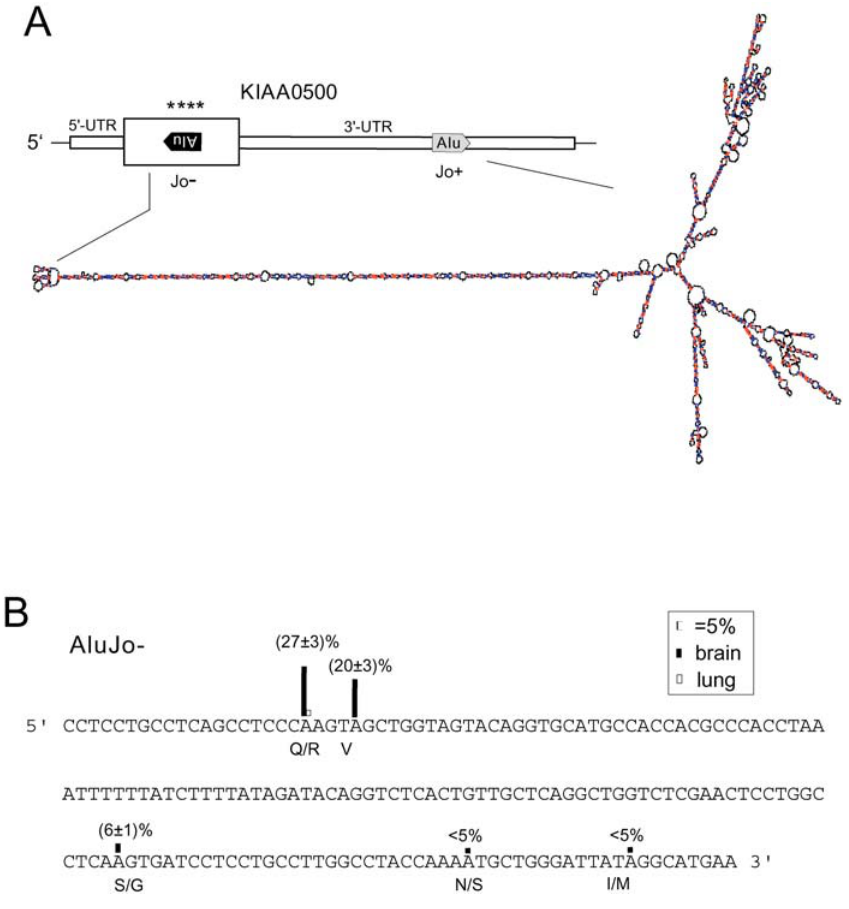
Figure 2. RNA Editing of KIAA500 Alu Inverted Repeat KIAA0500 is a cDNA of 6,577 nt in length cloned from human brain (AB007969) with a predicted open reading frame of 213 amino acids. Four AtoG discrepancies were present within the coding region of which two lead to an amino acid change (Q/R and S/G, respectively). (A) Structure of the KIAA500 mRNA with location of Alu elements indicated and the predicted RNA secondary structure according to the MFOLD algorithm. Large open box indicates predicted open reading frame. *, editing sites. (B) Editing analysis of an exonic Alu element in KIAA0500. Editing sites pre- dicted to change amino acids are indi- cated. Our analysis revealed a significant percentage of editing (%G) at the nucleo- tide positions 3518 (27% 6 3%), 3522 (20% 6 3%) and 3625 (6% 6 1%) and additional editing sites with less than 5% editing, whereas parallel analysis of hu- man gDNA confirmed the presence of adenosine at these positions. Editing levels in brain (filled column) and lung (open column, where detectable) are shown above each edited nucleotide. DOI: